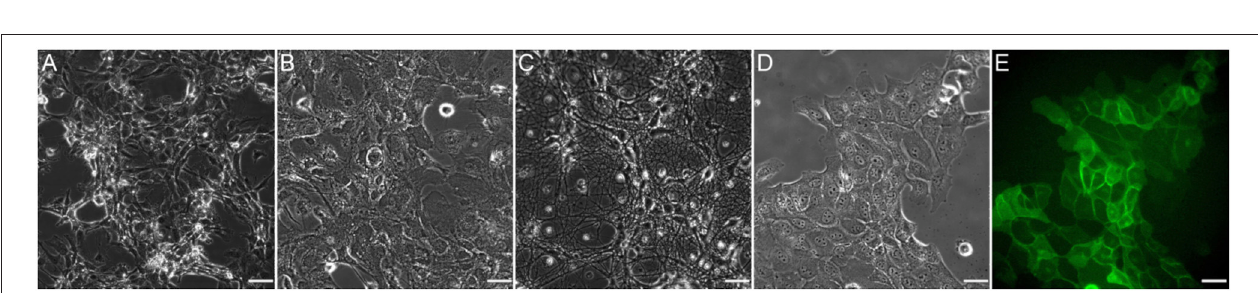
FIGURE 7 | An overview of the user interactions when unloading and loading cells for an experiment. (A) Removing the pin opens the flow chamber. (B) The glass slide hosting the incubated cells is placed in the lid. (C) Extra cell culture medium is added. (D) Inserting the pin closes the flow chamber. (E) The flow chamber itself is inserted into the device.